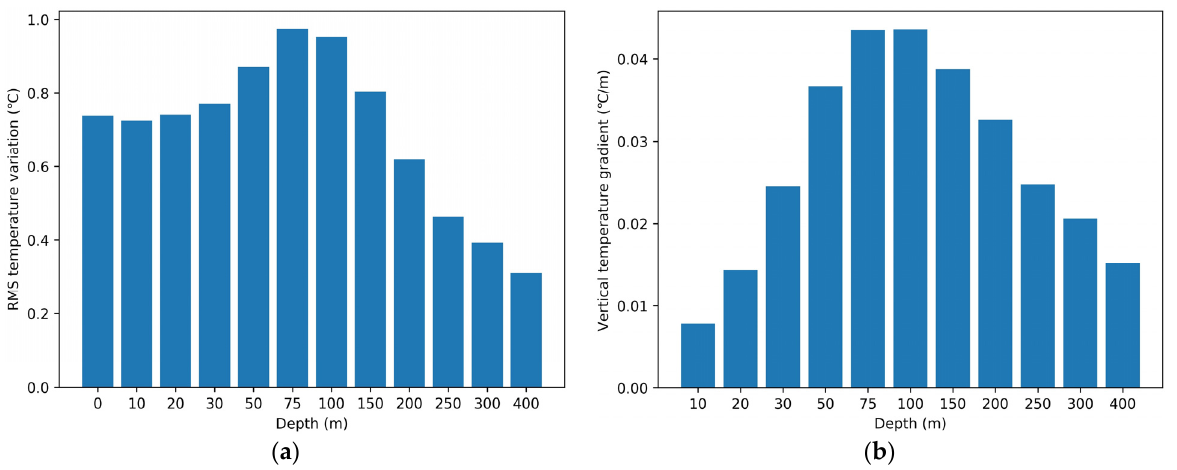
Figure 5. Average root-mean-square (RMS) temperature variations ( a ) and average vertical temper- ature gradients ( b ) at different depth levels in the study area.